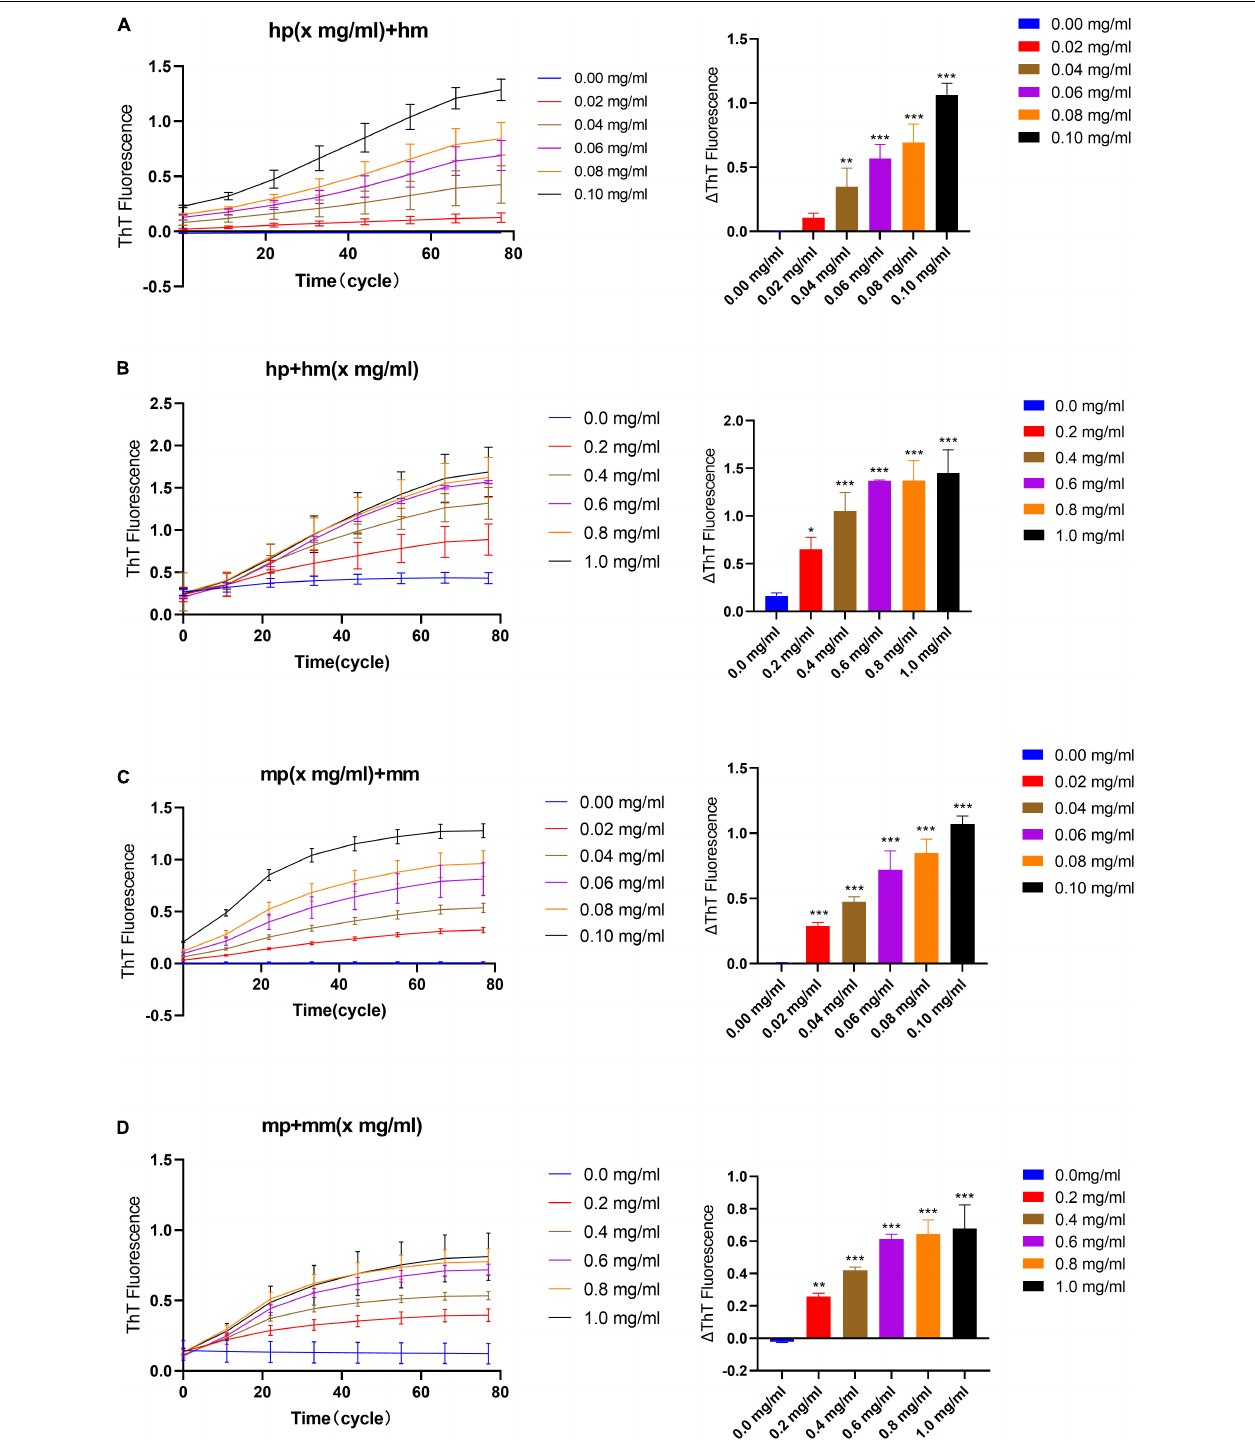
FIGURE 2 | The effect of seeds and monomer concentration on the quiescent incubation curve of fibril seeds. (A) Fluorescence curve of quiescent incubation of human fibril seeds with different concentrations at fixed monomer concentration, left. Corresponding (cid:49) ThT fluorescence value, right. (B) Fluorescence curve of the quiescent incubation of human fibril seeds at different monomer concentrations, left. Corresponding (cid:49) ThT fluorescence value, right. (C) Fluorescence curve of quiescent incubation of mouse fibril seeds with different concentrations at fixed monomer concentration, left. Corresponding (cid:49) ThT fluorescence change value, right. (D) Fluorescence curve of the quiescent incubation of mouse fibril seeds at different monomer concentrations, left. Corresponding (cid:49) ThT fluorescence value, right. All data are expressed in mean ± SD. Compared with the 0 mg/ml group, * P < 0.05, ** P < 0.01, *** P < 0.001.